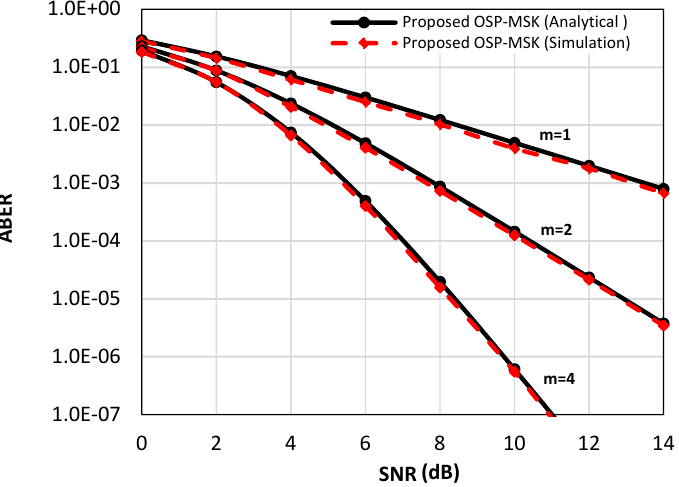
Figure 5. The analytical and the simulated ABER performance of the OSP-MSK modulation over the Raleigh fading channel and Nakagami-m fading channel for the coded scenario.